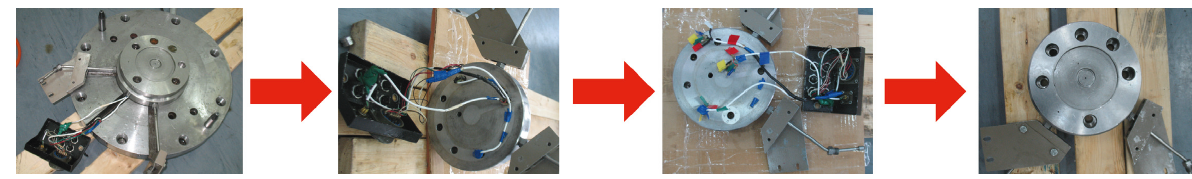
Figure 7: Removing the communication hole plugging device.